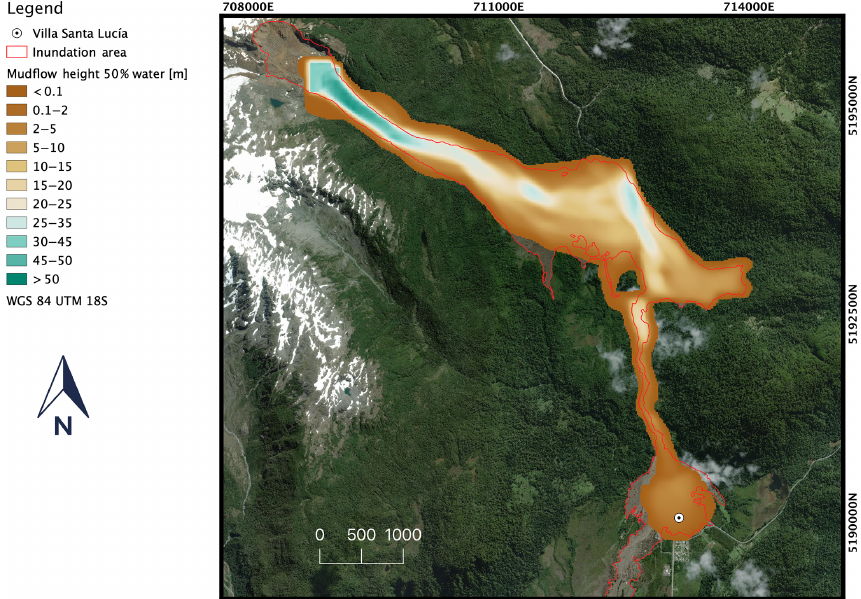
Figure 8. Model results of r.avaflow for a concentration by volume of 50% (background © ESRI).